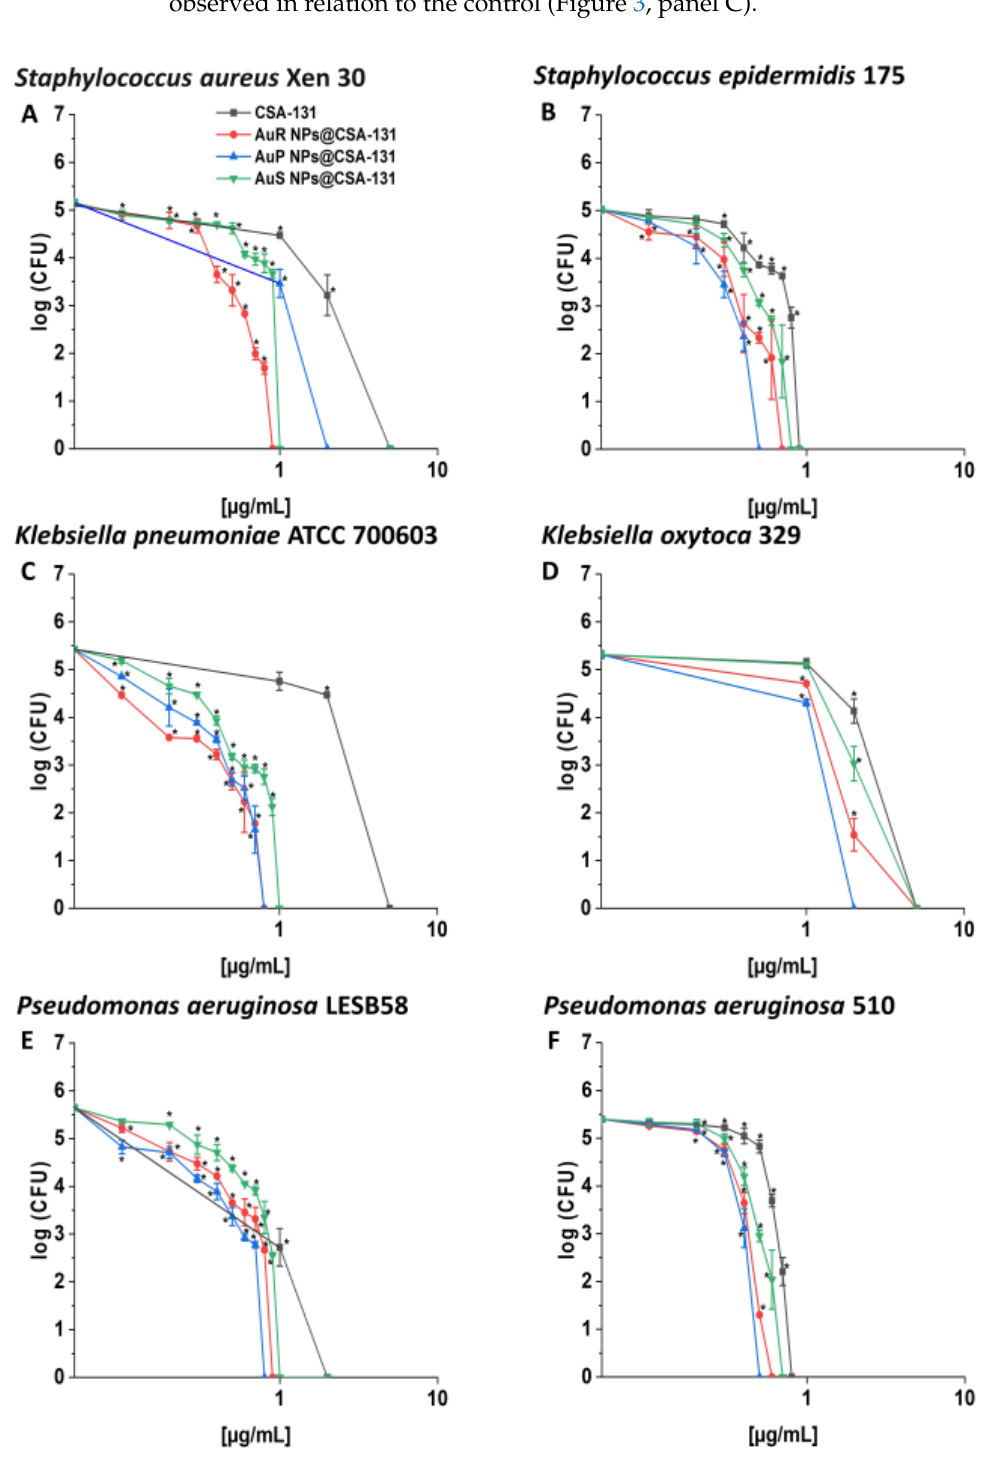
Figure 2. Bactericidal activity of AuR NP@CSA-131, AuP NP@CSA-131, AuS NP@CSA-131, and CSA-131 against Staphylococcus aureus Xen 30 ( A ), Staphylococcus epidermidis 175 ( B ), Klebsiella pneumoniae ATCC 700603 ( C ), Klebsiella oxytoca 329 ( D ), Pseudomonas aeruginosa LESB58 ( E ), and Pseudomonas aeruginosa 510 ( F ). Bactericidal activity of the nanosystems at concentrations of 0.1–10 µg/mL was determined using a standard colony counting assay. Results show the mean ± SD from six measurements. * indicates statistical significance at p ≤ 0.05.